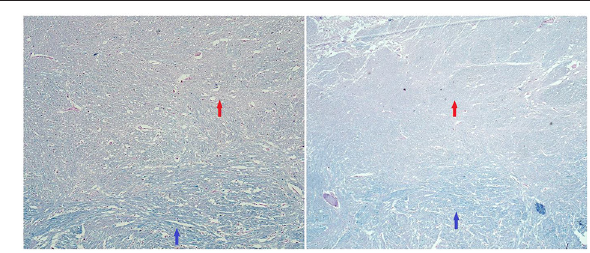
FIGURE 4 | Histopathological findings (tumefactive lesion in the left occipital lobe). Luxol fast blue/periodic acid–Schiff (PAS) staining. Red arrows: area of demyelination in plaque (pinkish color of PAS). Blue arrows: areas of normal myelination (bluish staining of myelin by luxol fast blue) (100 × magnification/50 ×